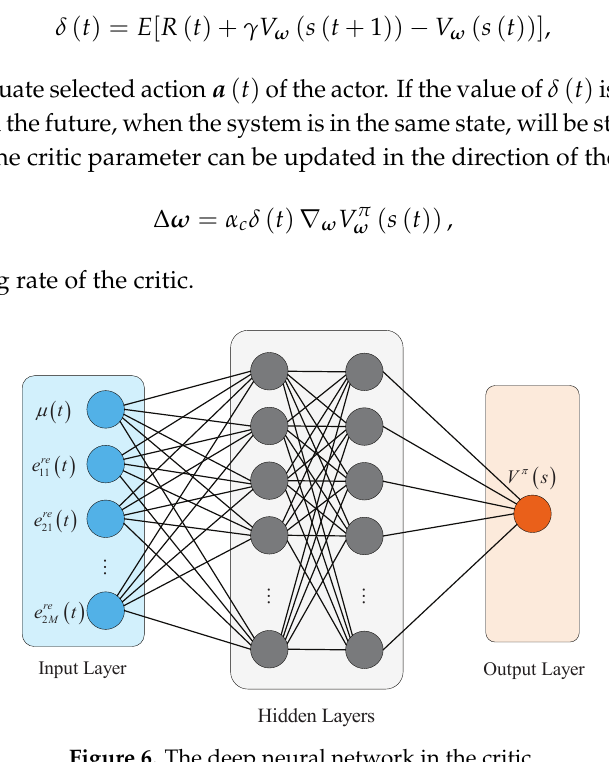
Figure 6. The deep neural network in the